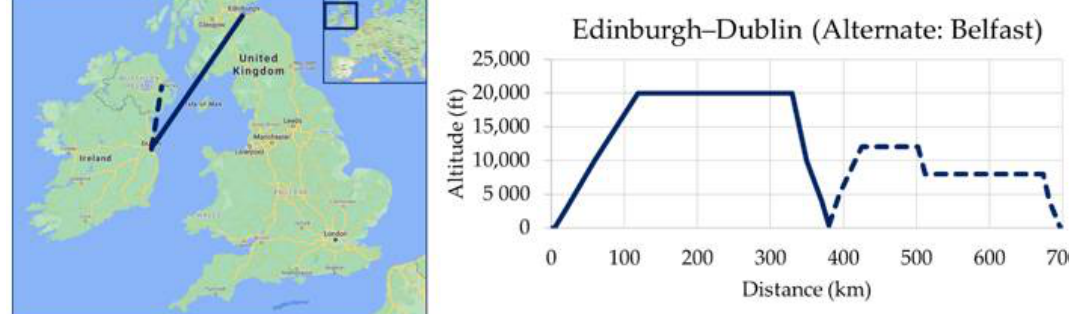
Figure 12. Exemplary flight route and profile of the design range mission EDI–DUB (Edinburgh, United Kingdom to Dublin, Ireland) (including the flight to the alternate BFS (Belfast) and a holding of 30 min).